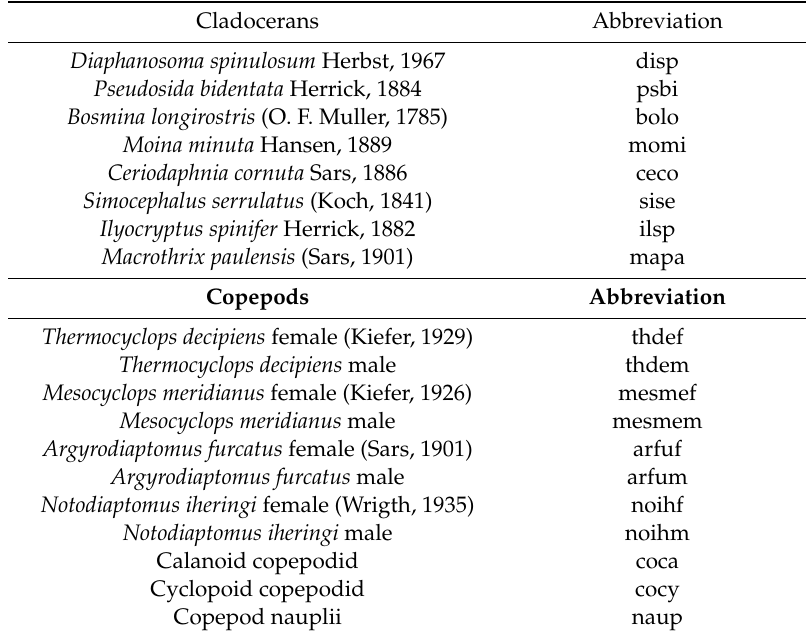
Table 2. List of microcrustacean species found in the experimental mesocosms and their abbreviations. Cladocerans Abbreviation Diaphanosoma spinulosum Herbst, 1967 disp